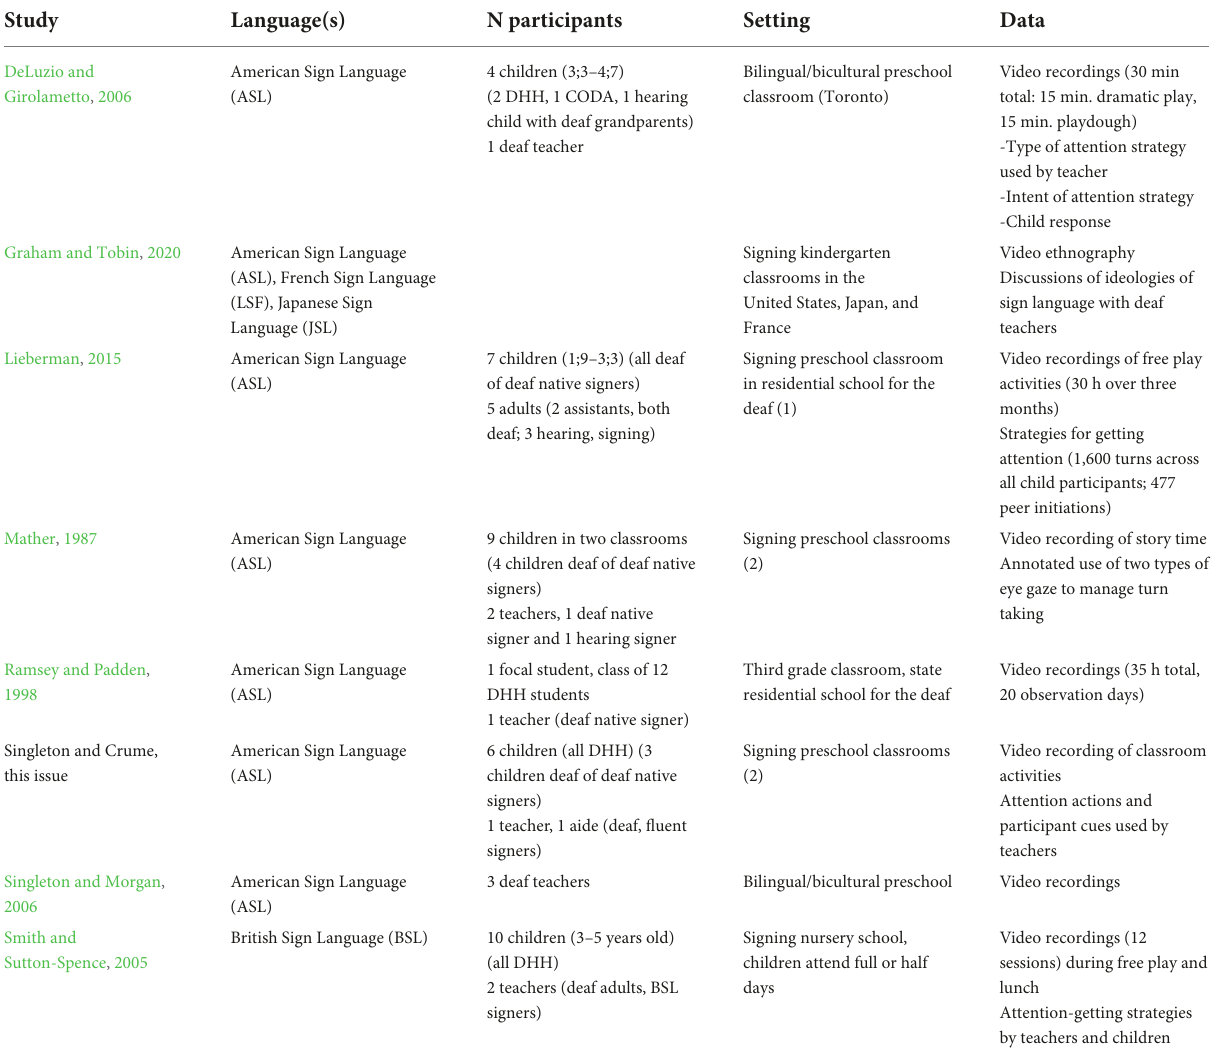
TABLE 7 Studies of taking turns and getting attention in signing